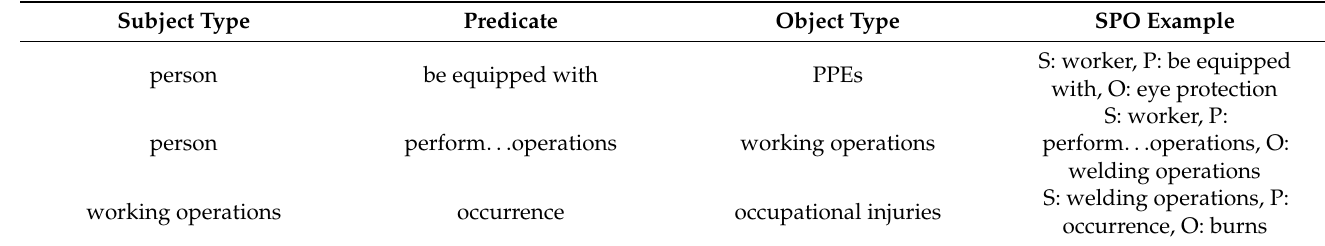
Table 1. Schema examples in regulations